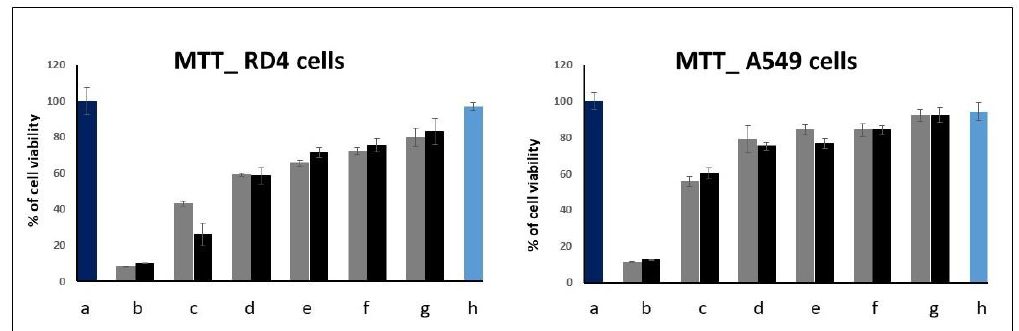
Figure 2. MTT test on RD4 (left) and A549 cells (right) for GP16_6: ( a ) untreated cells; ( b ) 40 µM; ( c ) 20 µM; ( d ) 10 µM; ( e ) 5 µM; ( f ) 2.5 µM; ( g ) 1.25 µM; ( h ) only DOPE. In gray, GP16_6 alone; in black, GP16_6: DOPE = 1:2. Values are the mean ± S.D. of three independent experiments ( n = 8 per treatment, p < 0.05).